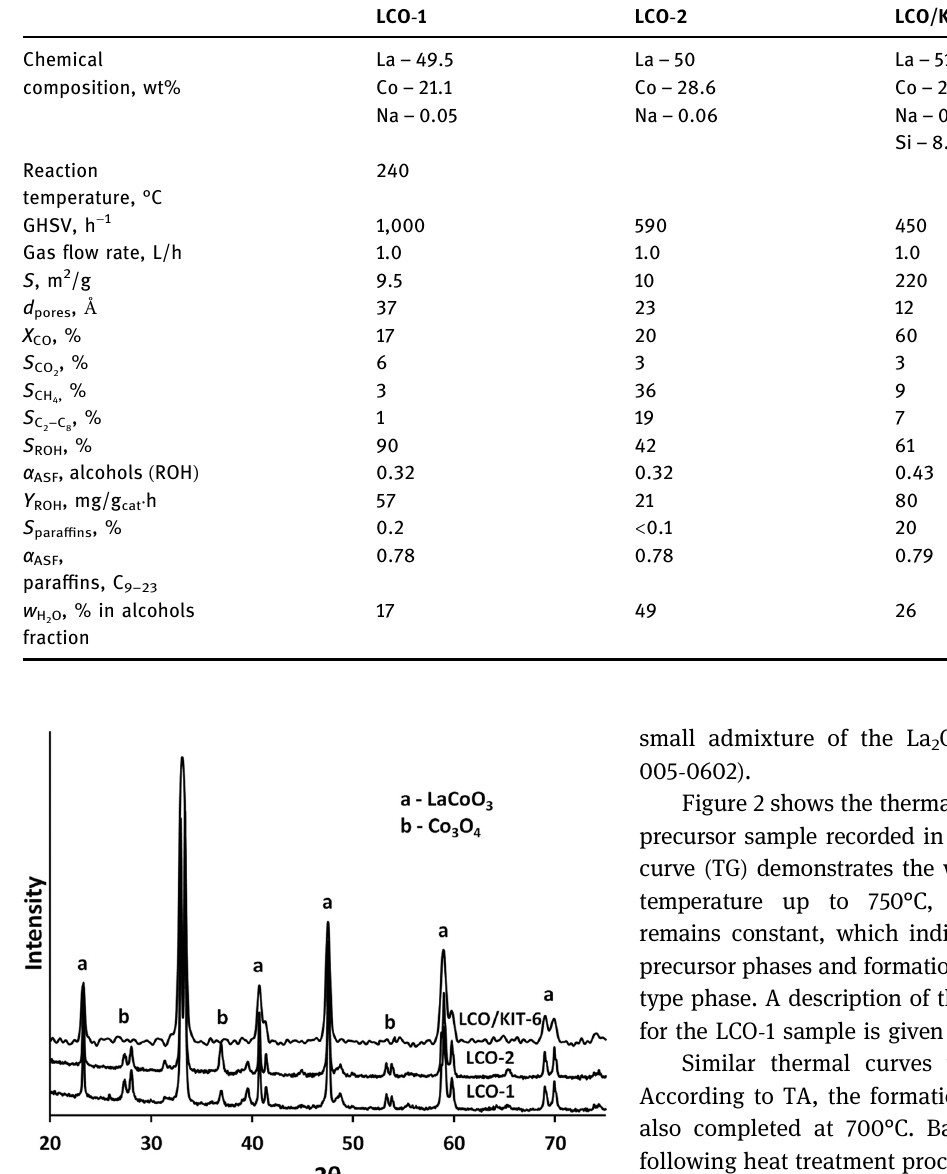
Table 2: Results of the catalytic tests in the syngas conversion at a pressure of 2 MPa. S is the selectivity of CO consumption for the corresponding reaction products, X is the conversion of CO, Y is the yield of alcohols, α ASF is the Anderson – Schulz – Flory parameter